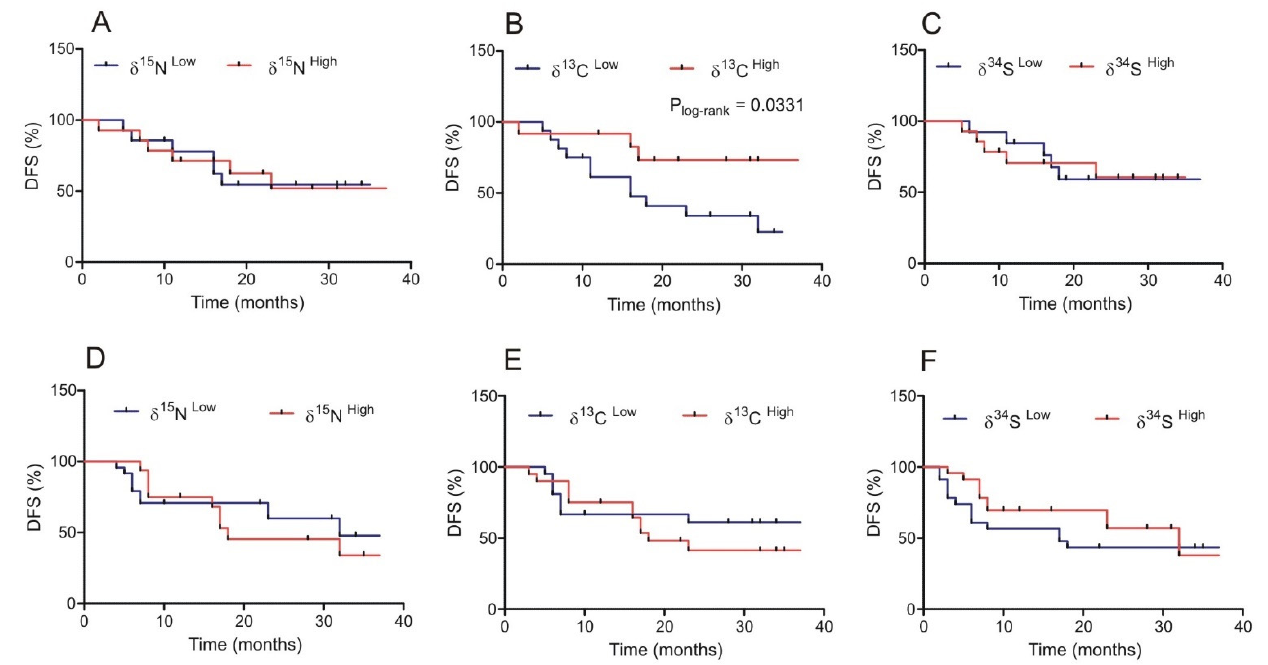
Figure 3. Correlation between the abundance of 15 N, 13 C, and 34 S isotopes in normal urothelium ( A – C ) and bladder cancer specimens ( D – F ) and disease-free survival (DFS) in patients.